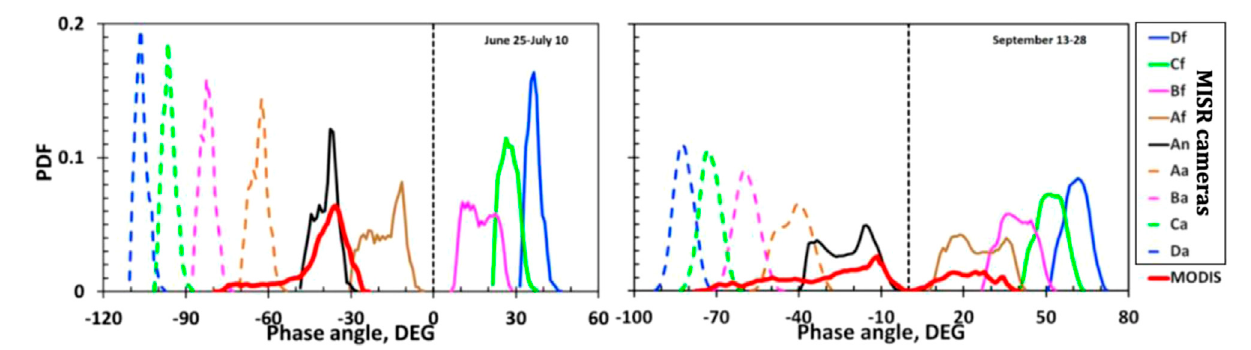
FIGURE7| Probability density function(pdf) ofthe phase angle during 25June to10Julyand 13 – 28September periods over Amazonian rainforests (0 ° – 10 ° Sand 60 ° W to 70 ° W) for Terra MODIS and MISR sun-sensor geometries derived from MODIS and MISR data acquired from June 2000 to May 2008. MISR instrument uses nine cameras to view the Earth ’ s surface in the forward and backward directions along the spacecraft ’ s fl ight track with nominal viewing zenith angles relative to the surface reference ellipsoid of 0.0 ° (camera An), 26.1 ° (Af and Aa), 46.5 ° (Bf and Ba), 60.0 ° (Cf and Ca), and 70.5 ° (Df and Da). The 360 km swath width covers the globe in 9 days. MODIS is a single view sensor that scans the Earth ’ s surface across the spacecraft fl ight track. It has a viewing swath width of 2,330 km and views the entire surface of the Earth every 1 – 2 days. From Song et al., 2018.